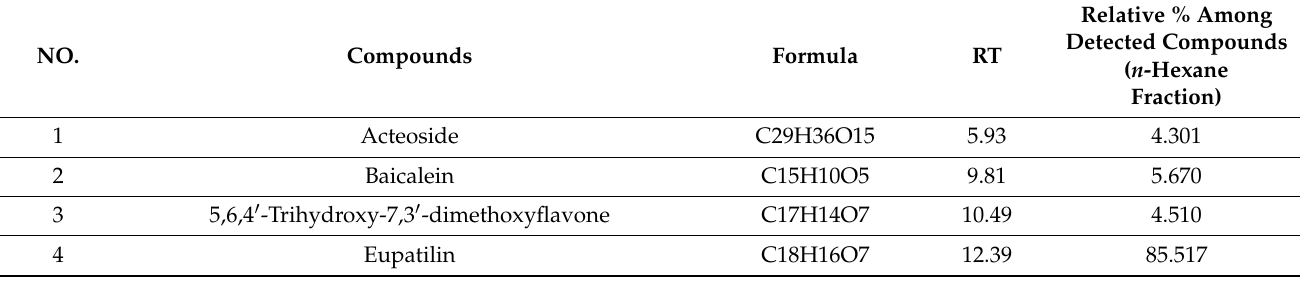
Table 3. LC-MS analysis of X. spinosum n -hexane